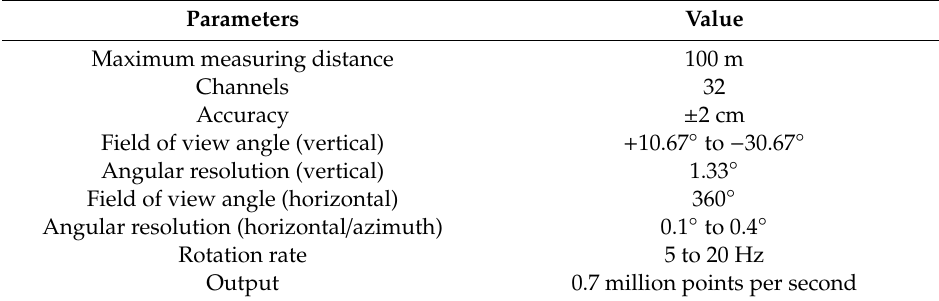
Figure 4. Velodyne LiDAR and laser scanning operation: ( a ) Velodyne HDL-32E LiDAR sensor; ( b ) laser scanning operation using the Velodyne HDL-32E LiDAR sensor. Table 1. Technical parameters of the Velodyne HDL-32E LiDAR sensor.